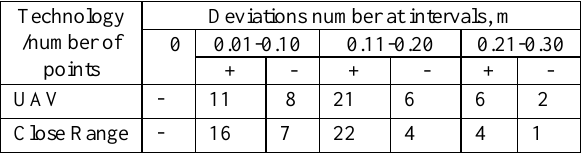
Table 1. Distribution of point’s numbers regarding to